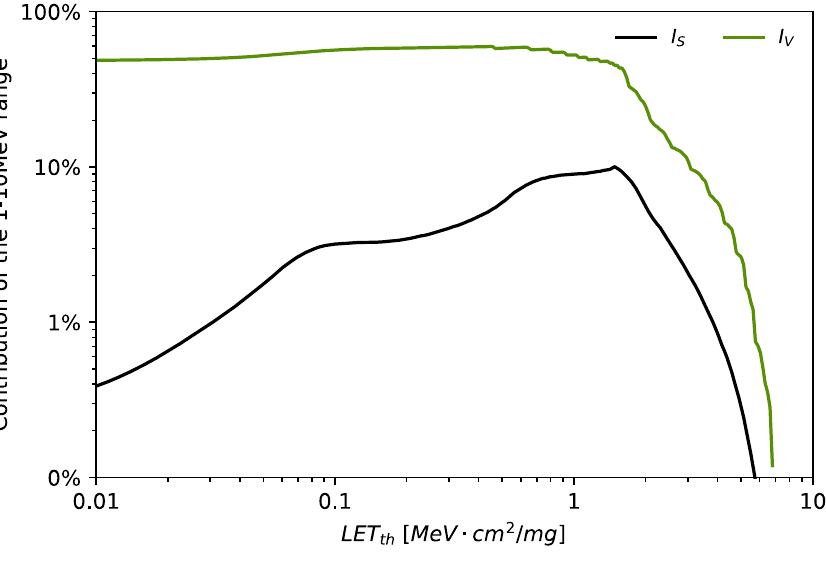
Figure 8. Relative contribution of the 1–10 MeV energy range compared to the 1–200 MeV range to the functions I S and I V as a function of threshold LET.